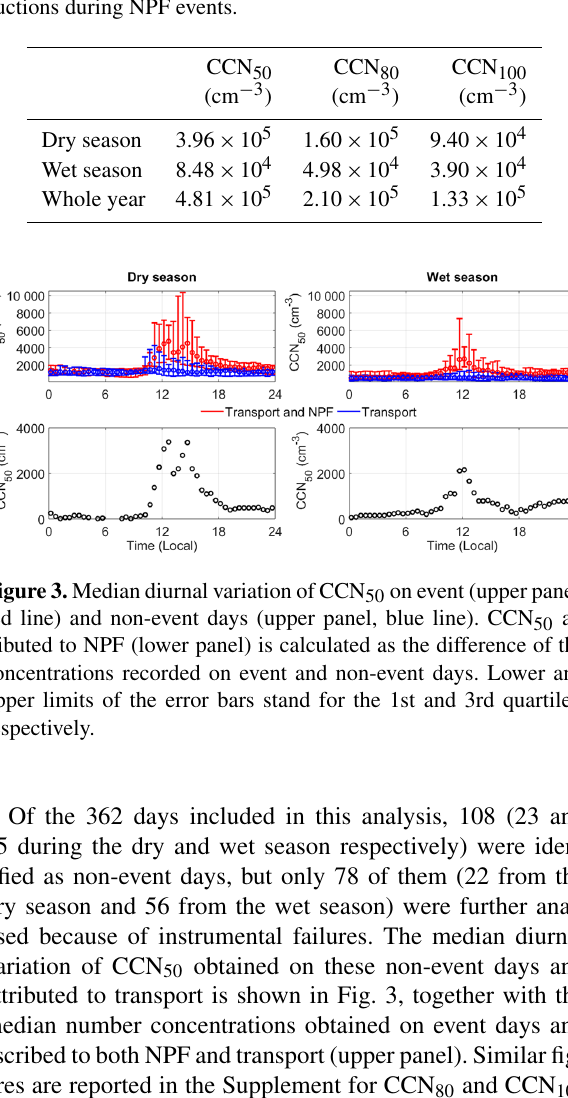
Table 1. Estimation of the median seasonal and annual CCN pro- ductions during NPF events.